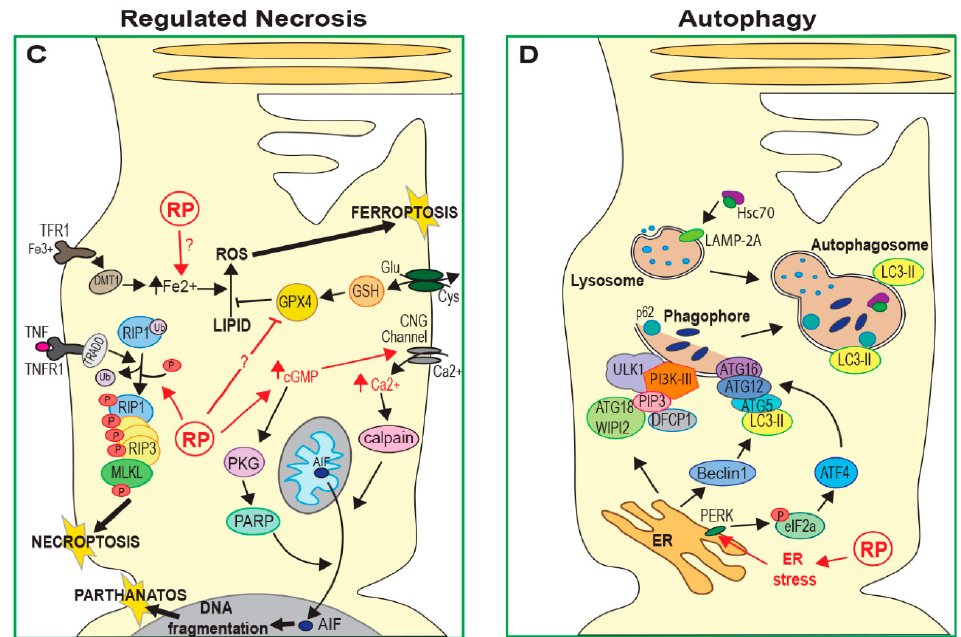
Figure 1. Cell death mechanisms in Retinitis pigmentosa (RP). ( A ) Schematic of a rod photoreceptor. ( B ) Both intrinsic pathways (through detection of cell damage) and extrinsic pathways (through